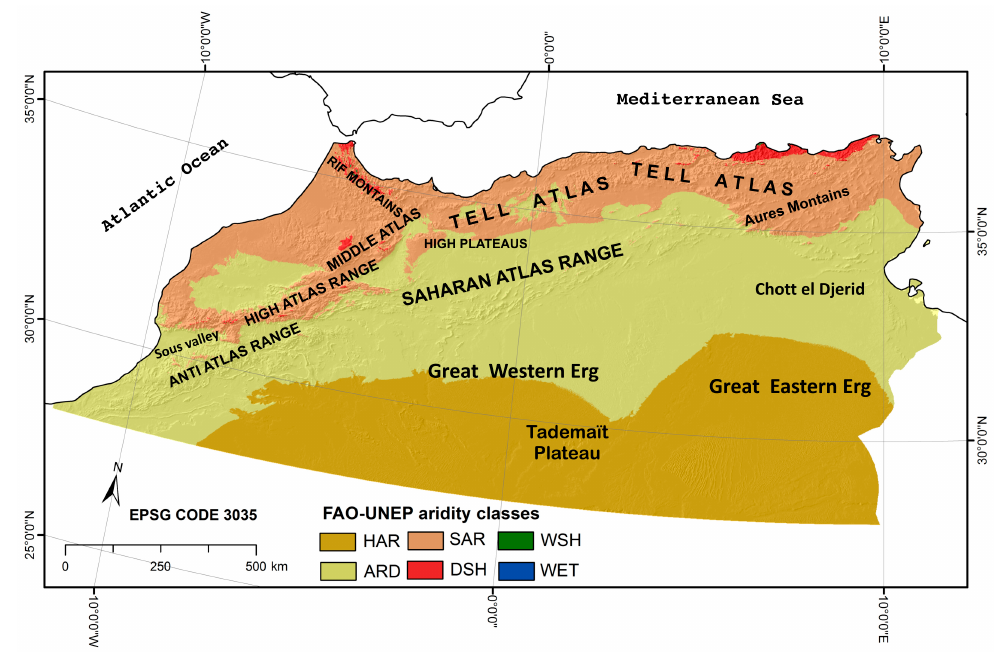
Figure 1. Location and main geographic features of NW Maghreb: major relief forms and mean annual aridity (1998–2008). FAO-UNEP classes shown: hyper-arid (HAR), arid (ARD), semi-arid (SAR), dry sub-humid (DSH), wet sub-humid (WSH) and wet (WET). EPSG Code 3035: Lambert Azimuthal Equal Area projection, ETRS89 Datum.